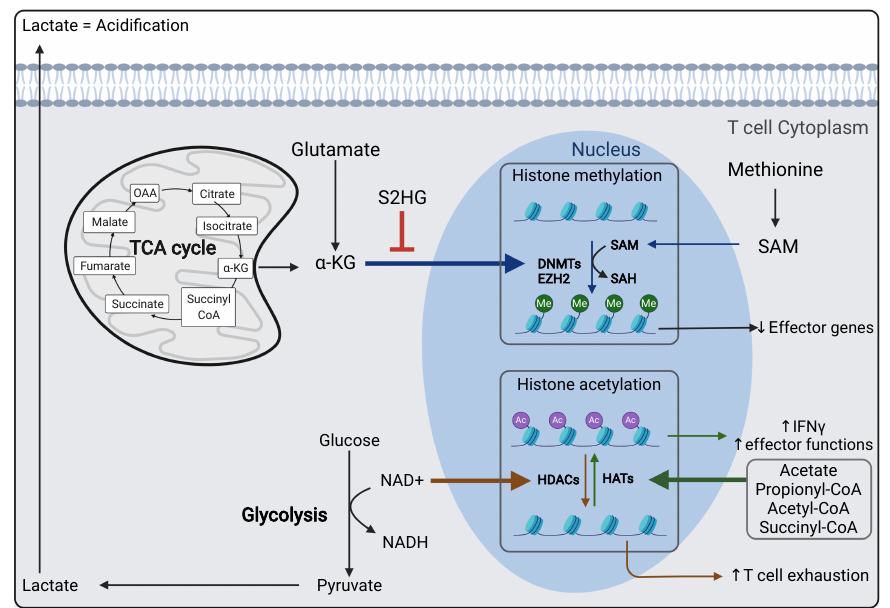
Figure 3. Immunometabolism shapes the epigenome of T cells. Here several of these epigenetic modifying pathways and metabolites influencing histone modification are outlined. OAA: Oxaloac- etate; a-KG: a-Ketoglutarate; S2HG: S-2-hydroxyglutarate; DNMTs: DNA methyltransferase; EZH2: Nicotinamide adenine dinucleotide; NADH: Nicotinamide adenine dinucleotide hydrogen;